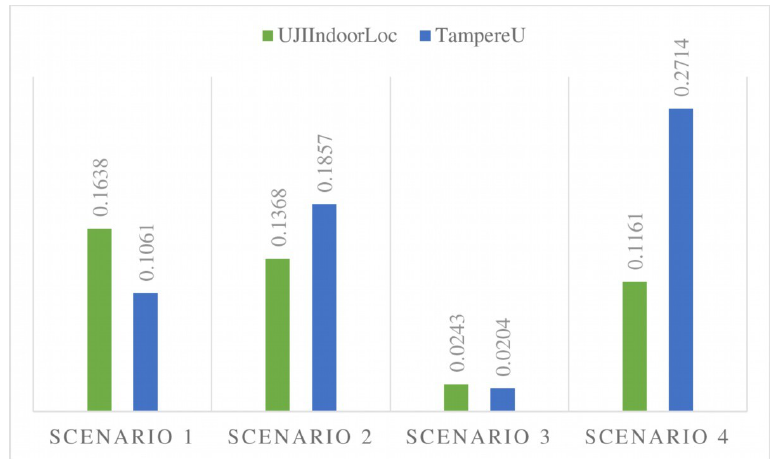
Figure 9. Maximum accuracy change for MFA-OSELM and FA-OSELM for all scenarios for the UJIIndoorLoc and TampereU datasets.